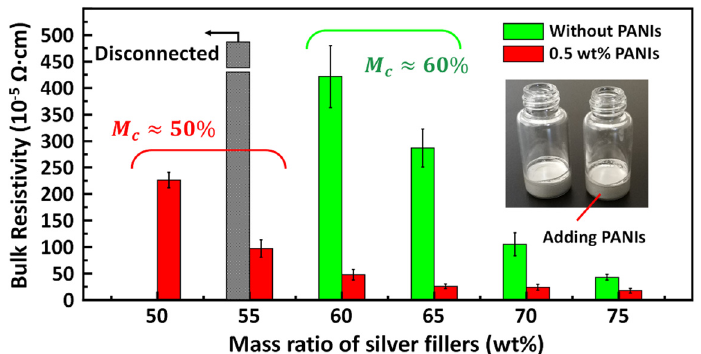
Figure 2. The comparison of bulk resistivity of electrically conductive adhesives (ECAs) between with 0.5 wt% or without PANIs dopants. Illustration shows the as-prepared silver-based ECA pastes with ( right ) or without ( left ) PANIs.